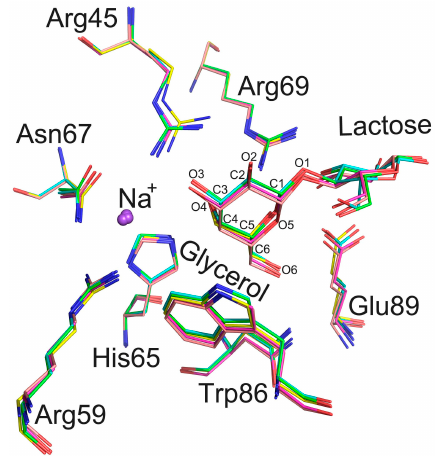
Figure 5. The carbohydrate binding sites of Gal-8_1-186 of five structures are merged. Nitrogen atoms are labeled by blue. Carbon atoms are labeled by red. The covalent bonds from structures 1–5 are labeled by yellow, purple, pink, cyan and green, respectively. The positions of residues (Arg45, His65, Asn67, Arg69, Trp86, and Glu89) could coordinate with glycerol and lactose. The C and O atoms of glycerol occupy the same sites as C4, C5, C6 and O1, O4, O6 of galactose. A Na + ion, observed in Gal-8_1-186 structures, is close to the carbohydrate binding site.